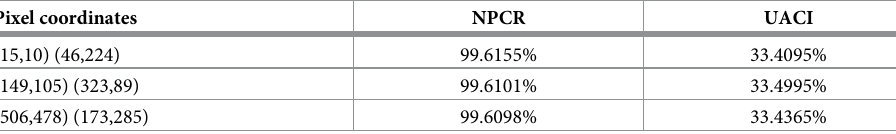
Table 17. Comparison table of NPCR and UACI with randomly changing 2 pixel. Pixel